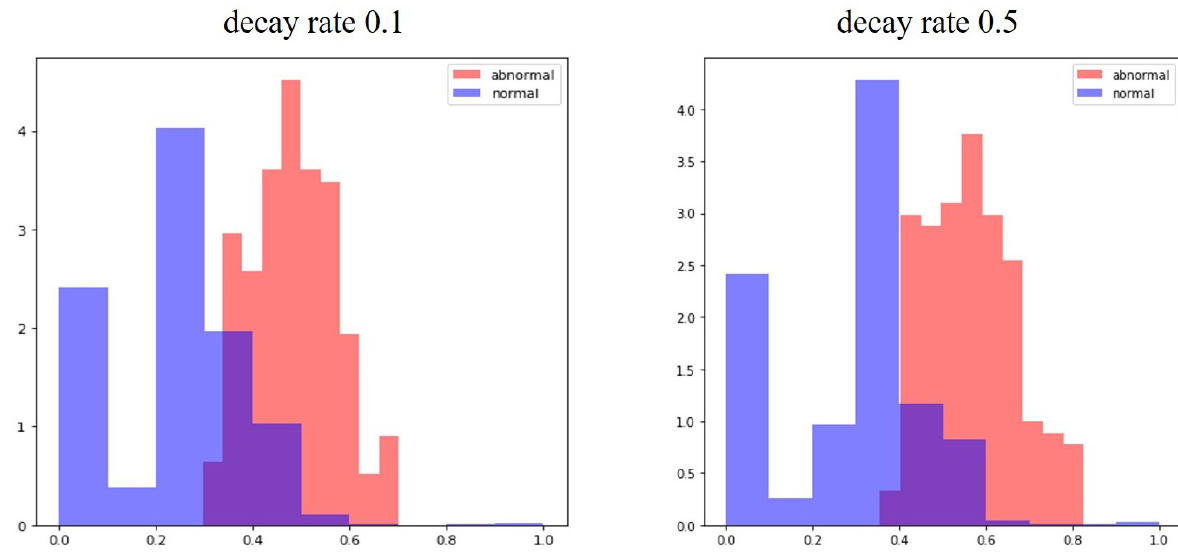
Figure 14. Distribution density map of different decay rates.